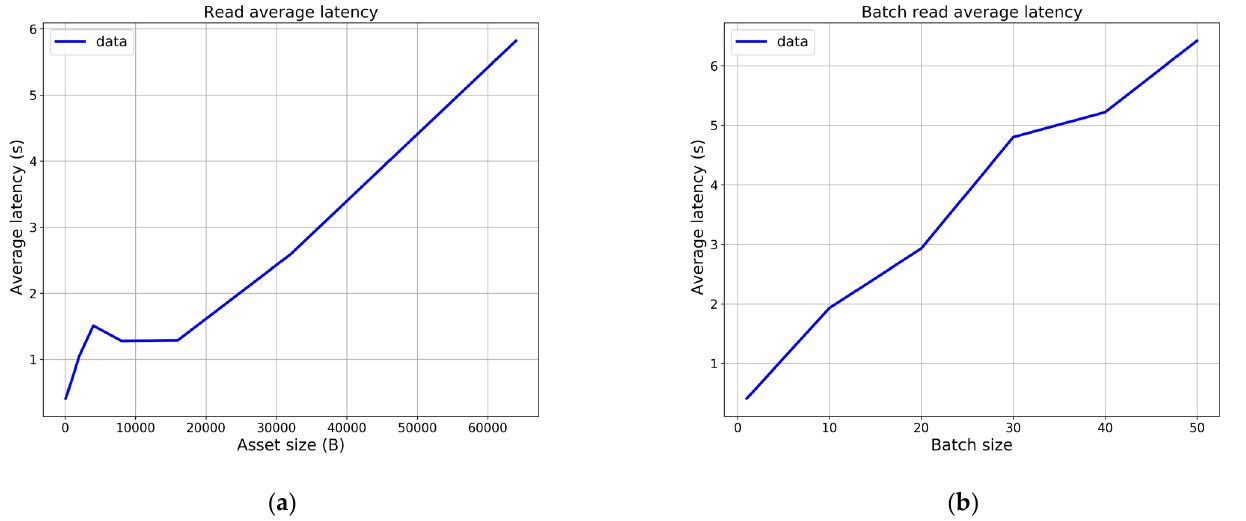
Figure 15. Read average latency ( a ) single read; ( b ) batch read.